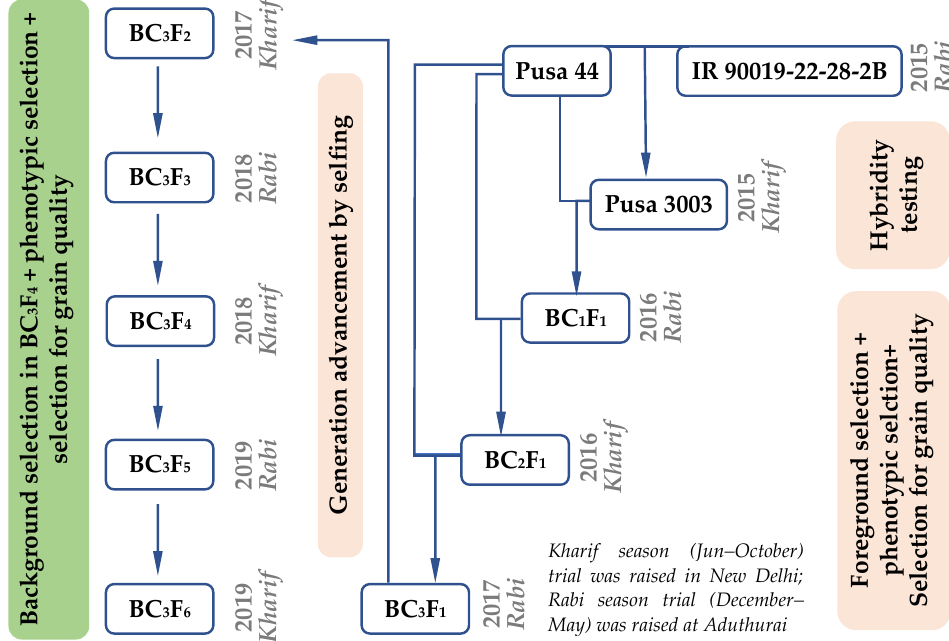
Figure 2. Breeding scheme adopted for the development of Pusa 44 qDTY12.1 -NILs.